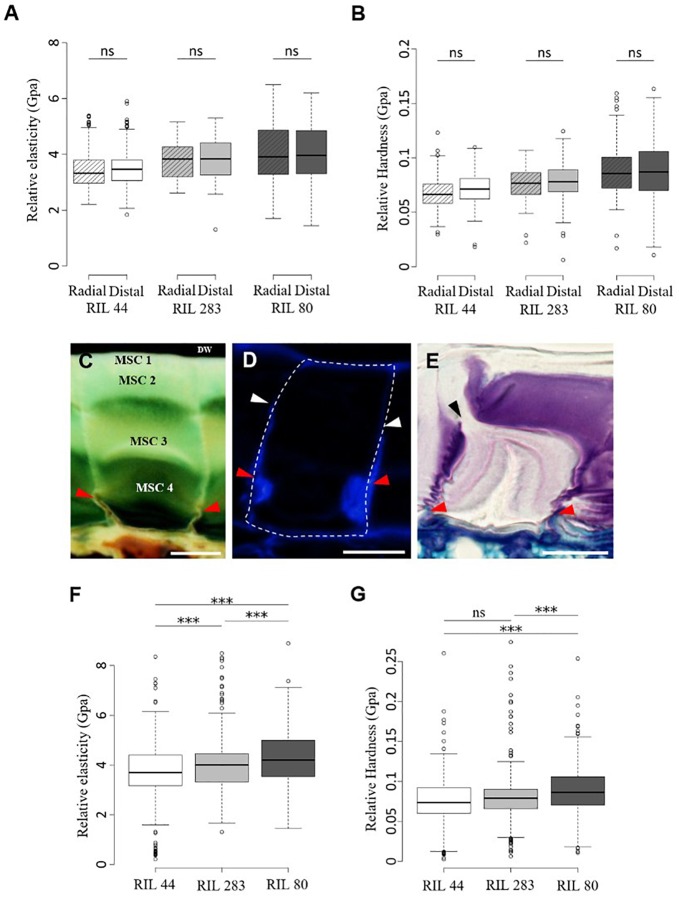
Mechanical forces that mediate mucilage release originate from inside MSCs. (A,B) Micro-indentation analysis of the rheological properties of the dried mature flax seed surface. Measurements of the relative elasticity (elastic moduli) (A) and hardness (B) were performed at the radial and distal walls surface in RIL 44 and selected RILs. (C–E) Cytological analysis of the radial wall structure of flax MSCs performed on RIL 44. Red arrowheads show structural reinforcement at the bottom of the radial walls. (C,E) Toluidine blue O-staining of flax seed coat sections. (D) Calcofluor White labeling of flax MSCs seems to reveal a secondary cell wall reinforcement that stops under MSC 2 (white arrowheads). (E) Picture illustrating the radial wall breaking point under MSC 2 (black arrowhead). (F,G) Measurements of the elastic moduli (F) and hardness (G) in RIL 44 and selected RILs combining data from radial and distal walls. Values are means of thirteen biological replicates with twenty measurements on each (n = 260 measurements per RIL, error bars denote SD, ∗∗∗P < 0.001, one-way ANOVA followed by a post hoc Tukey’s HSD). DW, distal primary cell wall. ns, not significant. Bars = 20 μm.